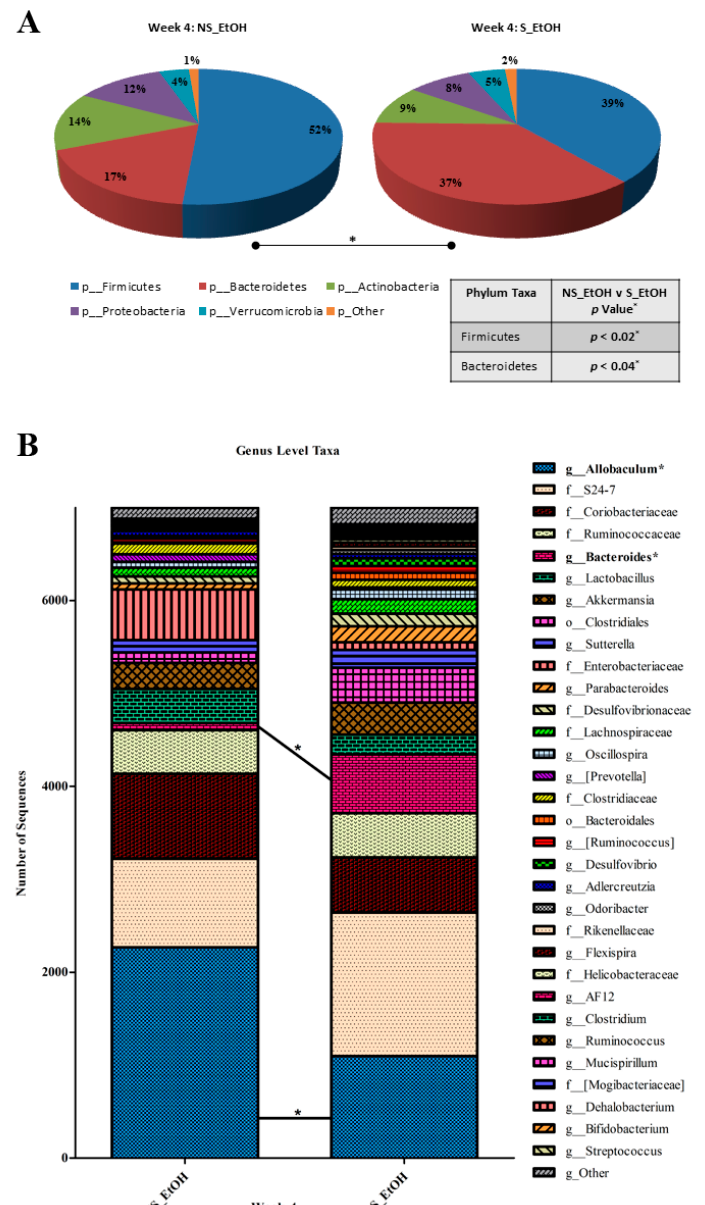
Figure 3. Light:dark (LD) shift changes microbiota in alcohol-fed mice. There were different relatively abundant phylum and genus microbial taxa in the fecal microbiomes of non-shifted, alcohol-fed mice (NS_EtOH) and LD shifted, alcohol-fed mice (S_EtOH) after four weeks of treatment. ( A ) The relative abundances of Bacteroidetes and Firmicutes, as well as ( B ) Allobaculum and Bacteroides are inversely proportional and different between NS_EtOH and S_EtOH mice feces. The average number of sequences was rarefied to 7000 sequences per sample. * denotes a significant difference between NS_EtOH and S_EtOH mice fecal samples.